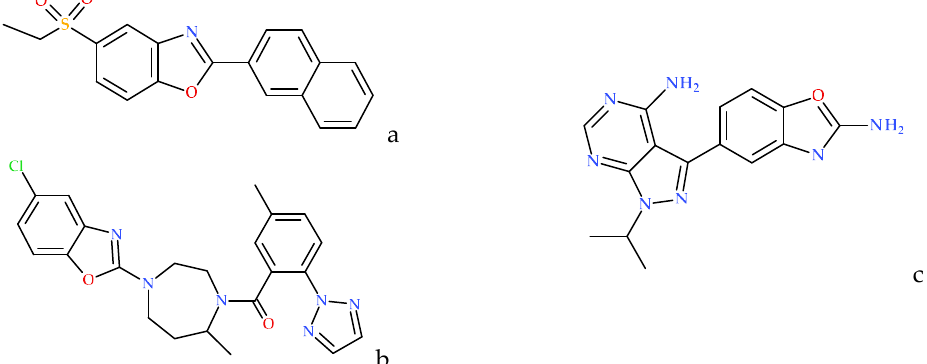
Figure 1. Benzoxazole compounds currently on the market ( a , b ) or in clinical trials ( c ). ( a ) Ezutromid is utrophin modulator indicated in Duchenne muscular dystrophy. ( b ) Suvorexant is selective, dual orexin receptor antagonist indicated in insomnia. ( c ) Sapanisertib is an mTOR inhibitor in clinical trials for treatment of different types of cancer.